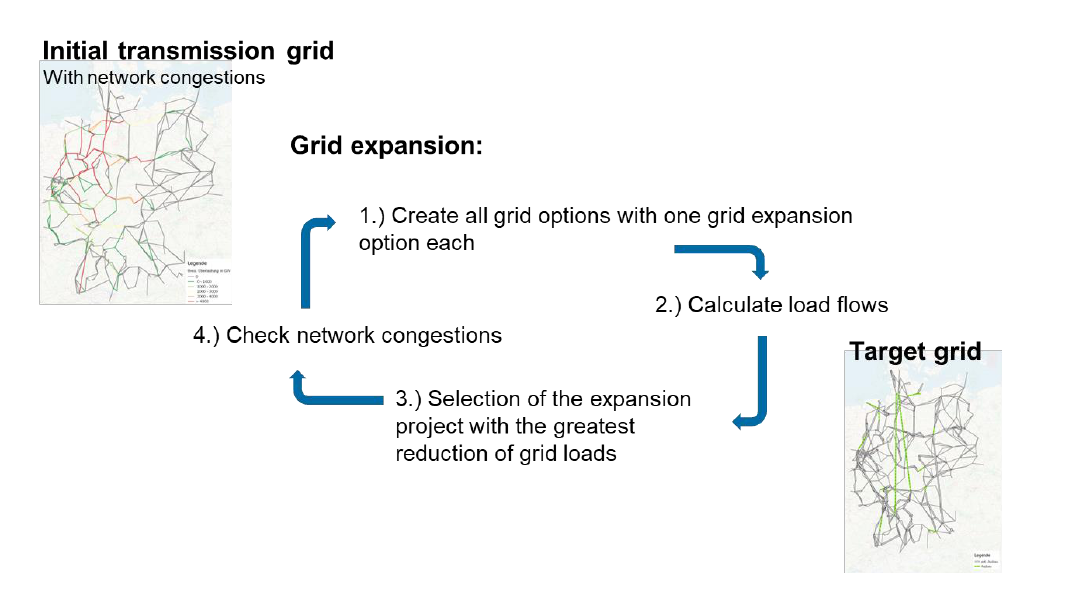
Figure 3. Sequence of iterative network expansion in the PowerFlex-Grid Model [44].